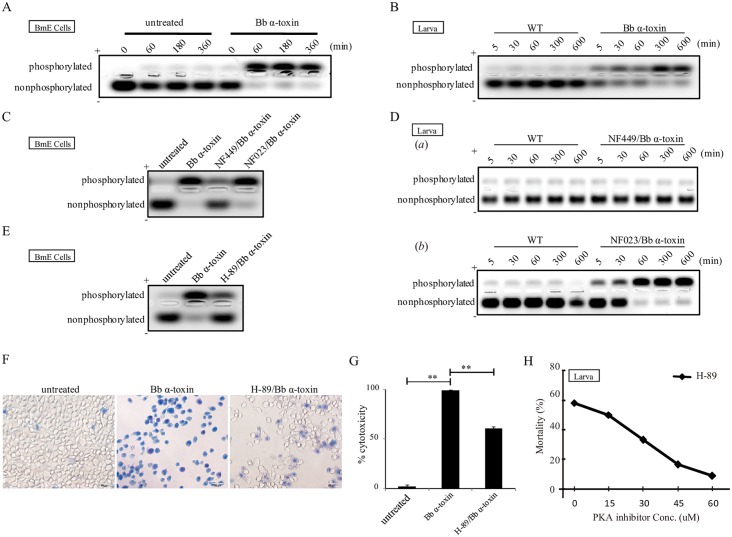
Requirement of PKA activity in Bb α-toxin protein induced larval lethality.Representative composite gel of cAMP-dependent phosphorylation of Kemptide; The far right lane represents PKA activity. (A) PKA activity was measured after Bb α-toxin protein treatment in BmE cells. (B) PKA activity of larvae following Bb α-toxin protein treatment in vivo. (C) Effect of PKA activity in the presence of NF449 (1μM) or NF023 (1μM) before the addition of Bb α-toxin protein at 50 μg/mL in BmE cell in vitro. (D) Assessment of PKA activity in the presence of NF0449 or NF023 with Bb α-toxin on the midgut in vivo. (E) Effect of PKA activity in the presence of cell-permeable inhibitors of PKA (H-89: 20 μM) with Bb α-toxin protein treatment. (F) Trypan blue staining of nuclei of BmE cells pre-treated with H-89 at 20 μM on Bb α-toxin cytotoxicity. Inhibitor-treated cells (H-89/Bb α-toxin) were protected from the toxic action of Bb α-toxin protein. Blue color represents dead cells; live cells appear colorless. (G) Relative cytotoxicity (%) of Bb α-toxin protein in the presence of H-89 inhibitor. (H) Percent relative mortality after Bb α-toxin with PKA inhibitor (0–60μM) for 30min at specified concentration before addition of Bb α-toxin protein.